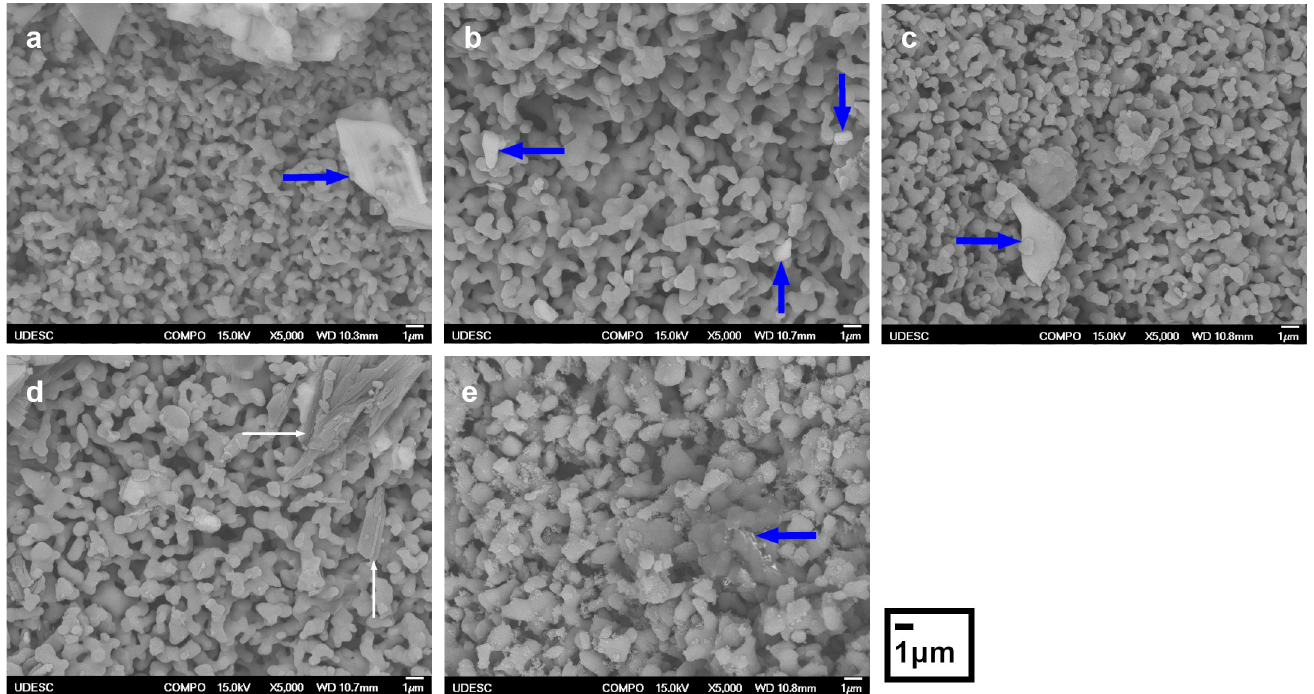
Fig 2. Morphology of precipitated drug onto calcium phosphate surface. Backscattered electron microscopy analysis of the biomaterials-carboplatin loading in the 70 mg/g concentration showing the micrometric carboplatin precipitate in (a) hydroxyapatite (HA), (b) β -tricalcium phosphate ( β -TCP) and (c) biphasic calcium phosphate (BCP); mannitol precipitate in (d) β -TCP/MgO nanocomposite; amorphous precipitate in (e) β -TCP/SiO 2 nanocomposite.